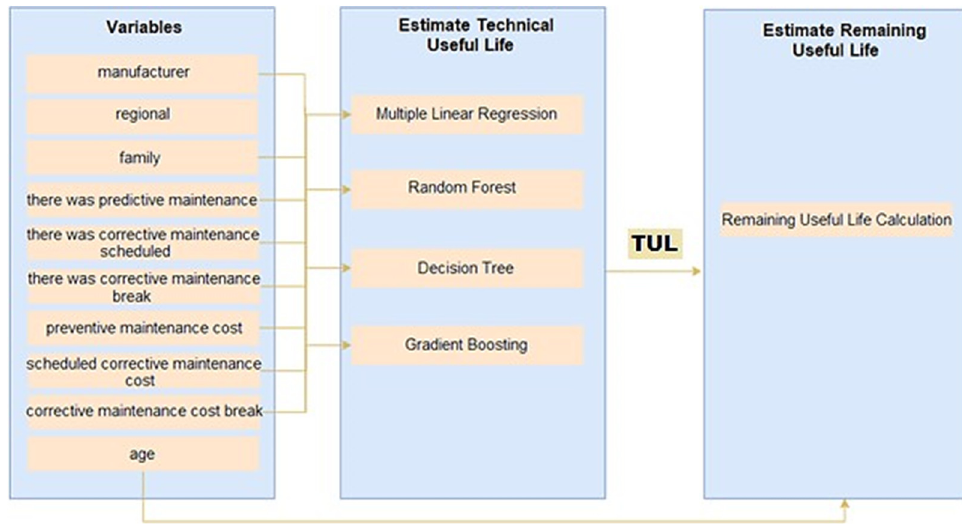
Figure 6. Main methodological flow for estimation of the RUL [authors].